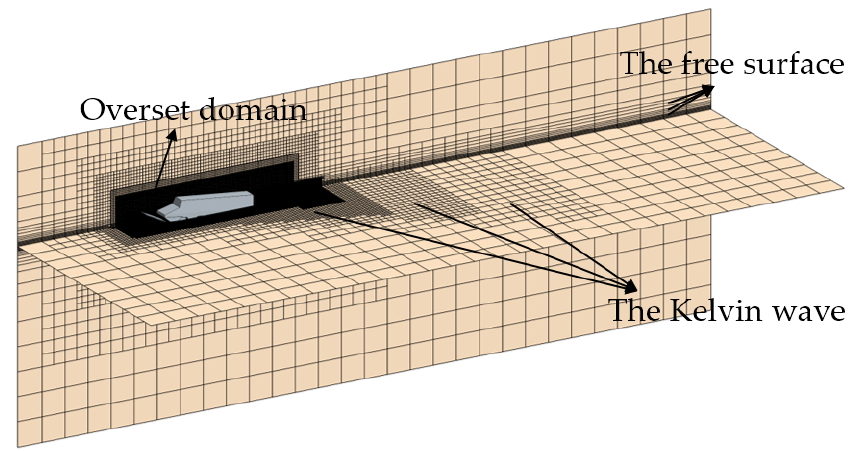
Figure 4. Grid distribution of the background domain.